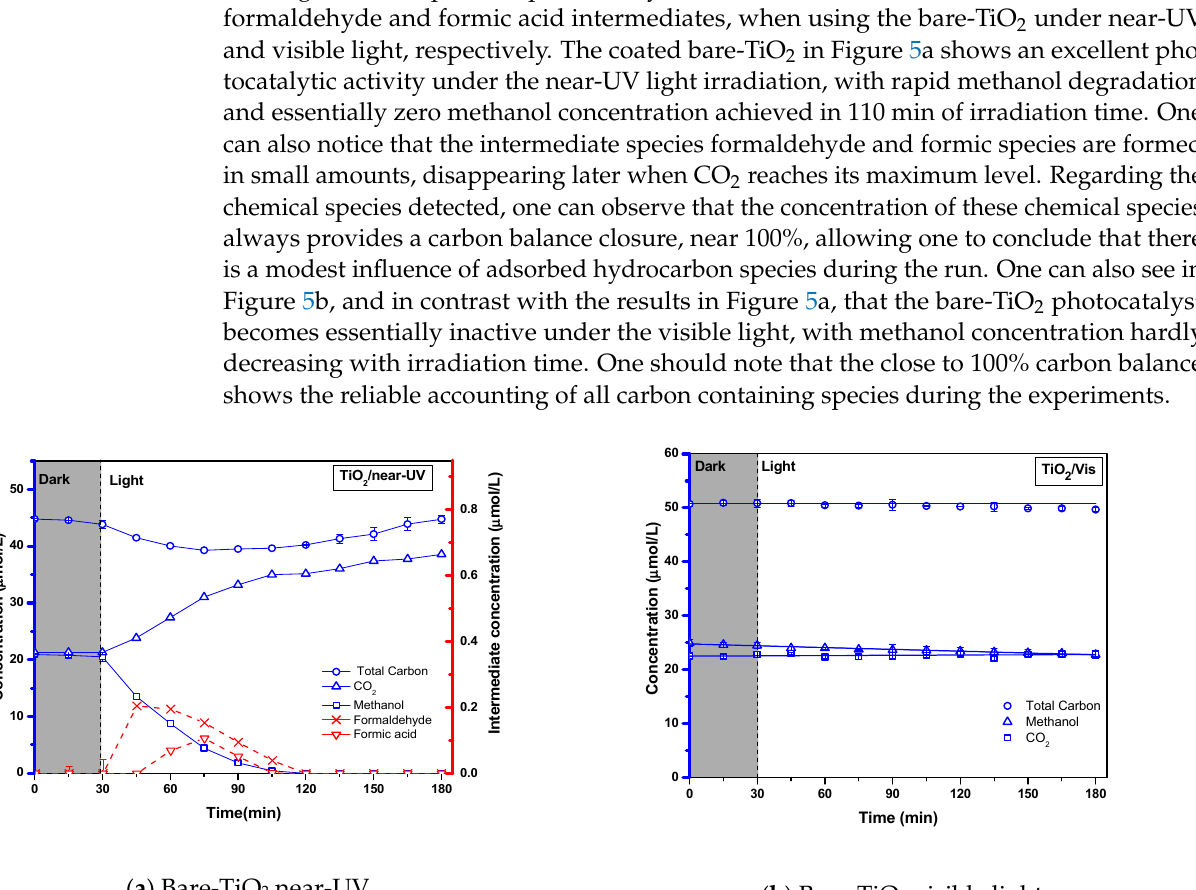
Total Carbon Methanol